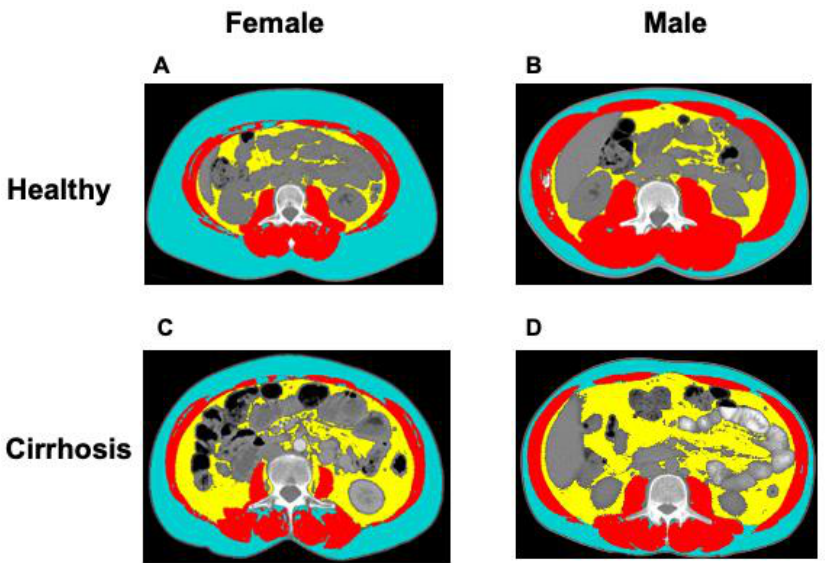
Figure 1. Abdominal computed tomography (CT) images taken at the 3rd. lumbar vertebra of healthy donors and patients with cirrhosis applied for body composition assessment. Example of body composition features in a ( A ) female healthy donor, ( B ) male healthy donor ( C ) female patient with cirrhosis, and ( D ) male patient with cirrhosis. Muscle, subcutaneous, and visceral adipose tissue are shown in red, blue, and yellow, respectively.